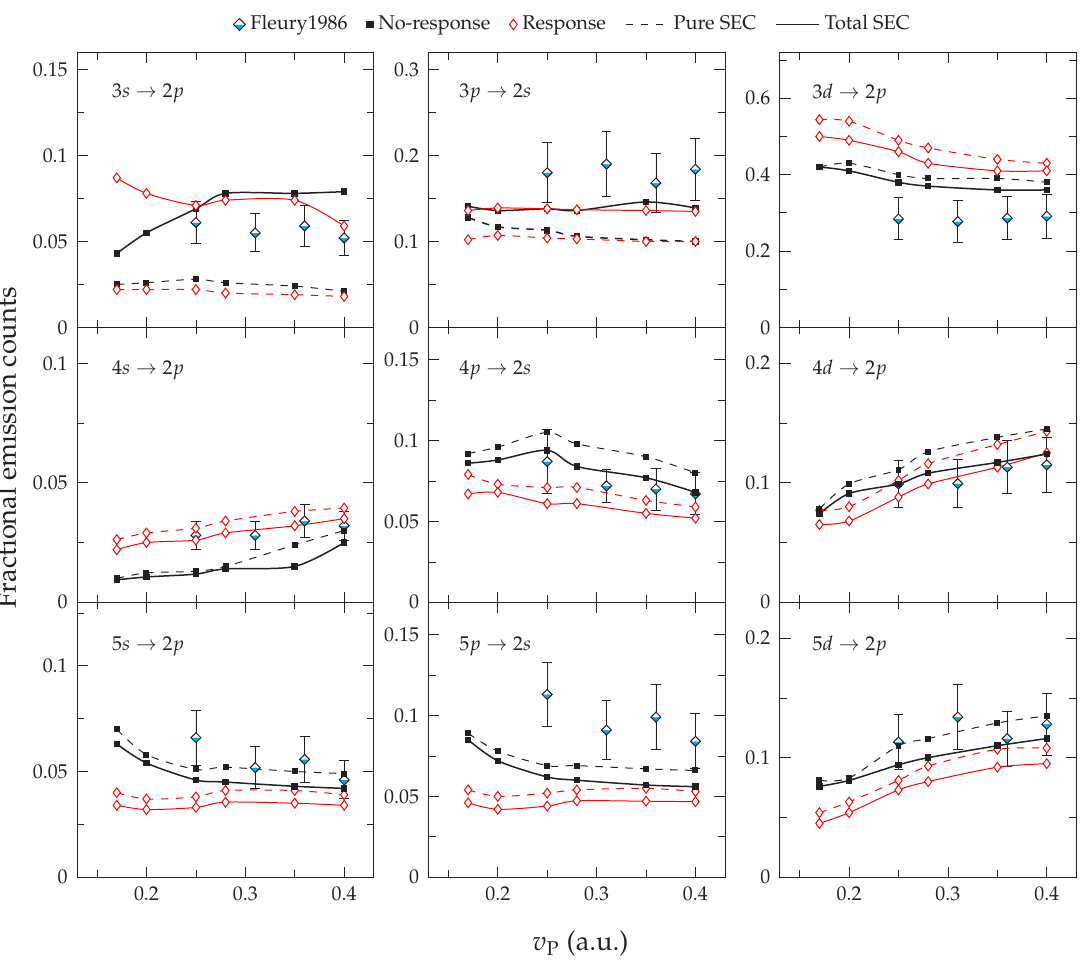
Figure 4. Fractions of line emissions with respect to impact speed from charge-exchange Ne 8+ –H 2 collisions. Experiment: Fleury et al. [16]. Theory: present work separated in pure SEC (dashed lines) and total SEC (solid